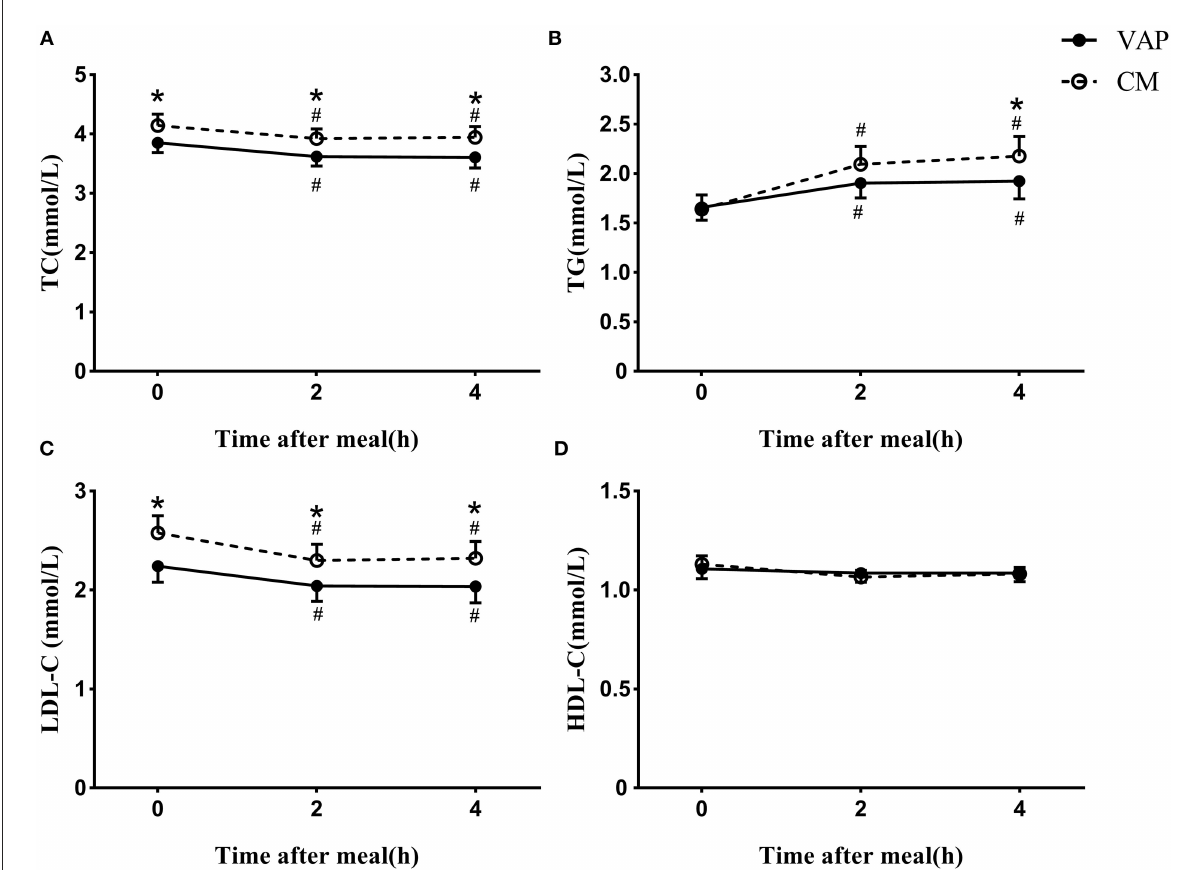
FIGURE1 Changes in serum levels of blood lipids via VAP and chemical masking method after a daily meal. * P < 0.05 when compared with VAP measured values at the same time point. # P < 0.05 when compared with fasting value using the same measure